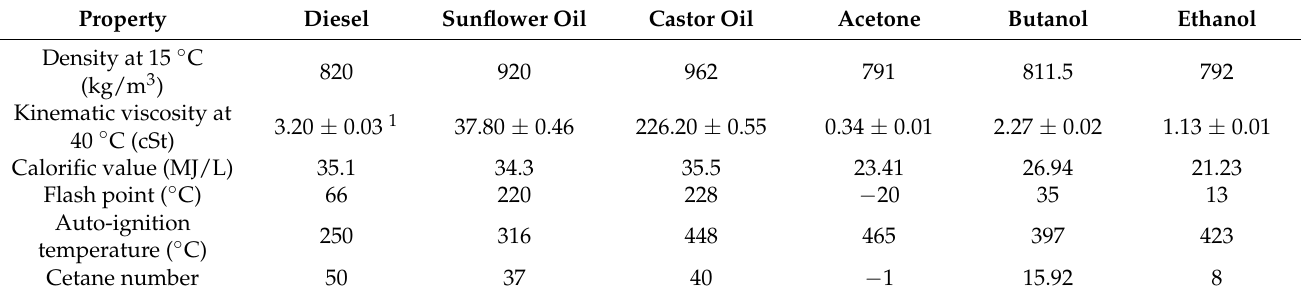
Table 3. Physicochemical properties of the different components of the fuel blends [23,27,35]. The kinematic viscosity values were experimentally determined in the present